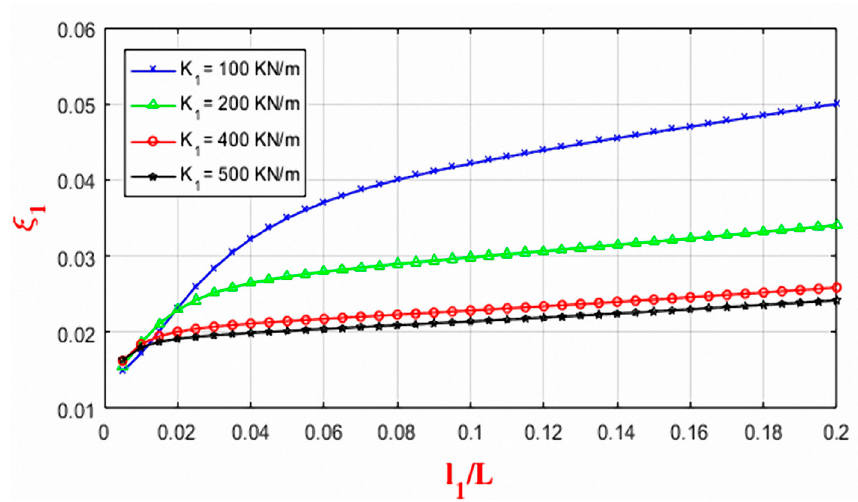
Figure 8. Relationship of ξ 1 and l 1 / L with different K 1 .